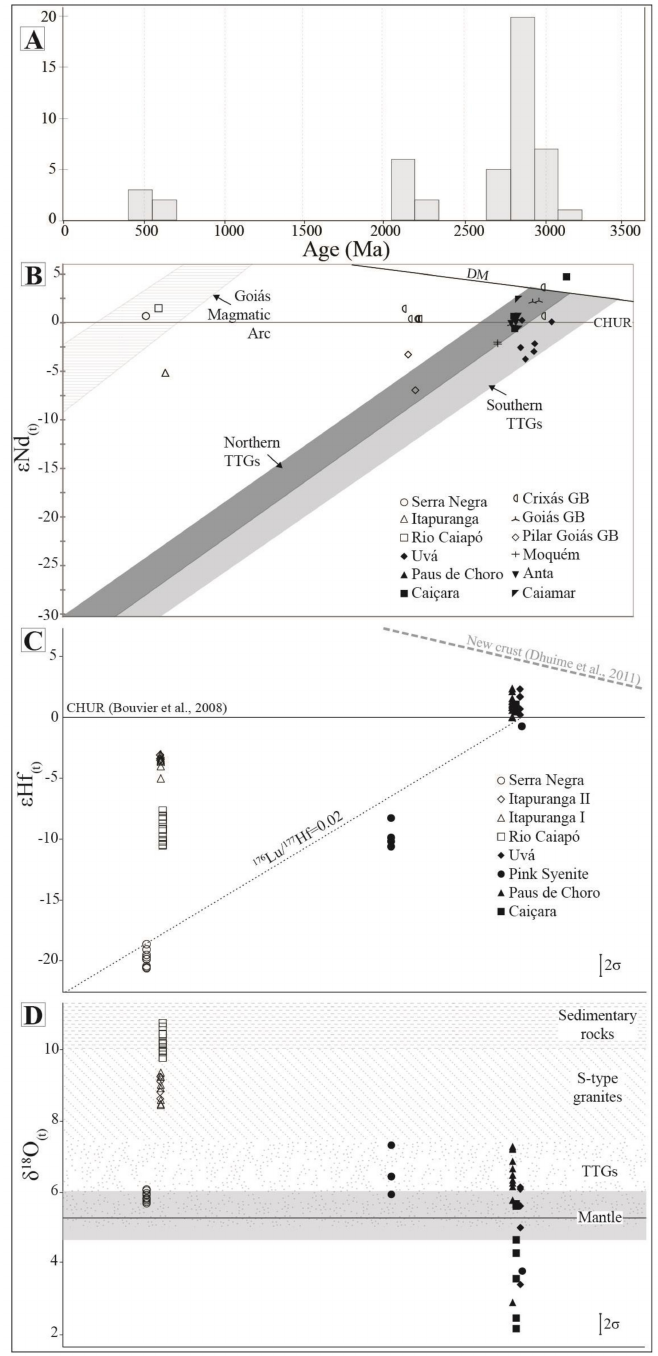
Figure 6. ( A ) Histogram of crystallization ages for igneous rocks in the GAB; ( B ) previously published ε Nd(T) data for supracrustal rocks and felsic magmatic rocks in the GAB [21,23,25,26,75,77,87,147,150–152]; ( C ) zircon ε Hf(T) isotope data for the southern GAB (error bar indicated at 2 σ ), and ( D ) zircon δ 18 O isotope composition for granitic intrusions in the southern GAB (error bar indicated at 2 σ